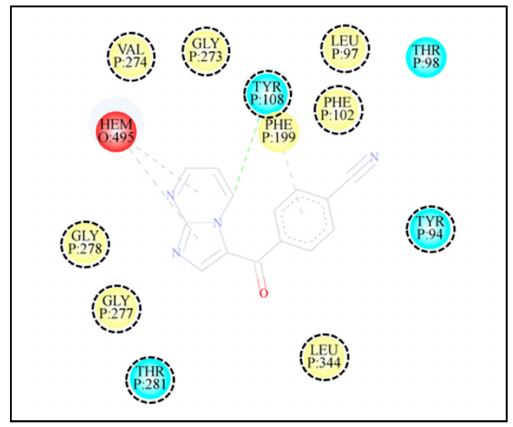
Figure 4. Schematic representation of the interactions between compound 4f and CYP51 Ck . The dashed lines indicate the amino acids in the five 3-benzoyl imidazo[1,2- a ]pyrimidines and the two reference compounds.